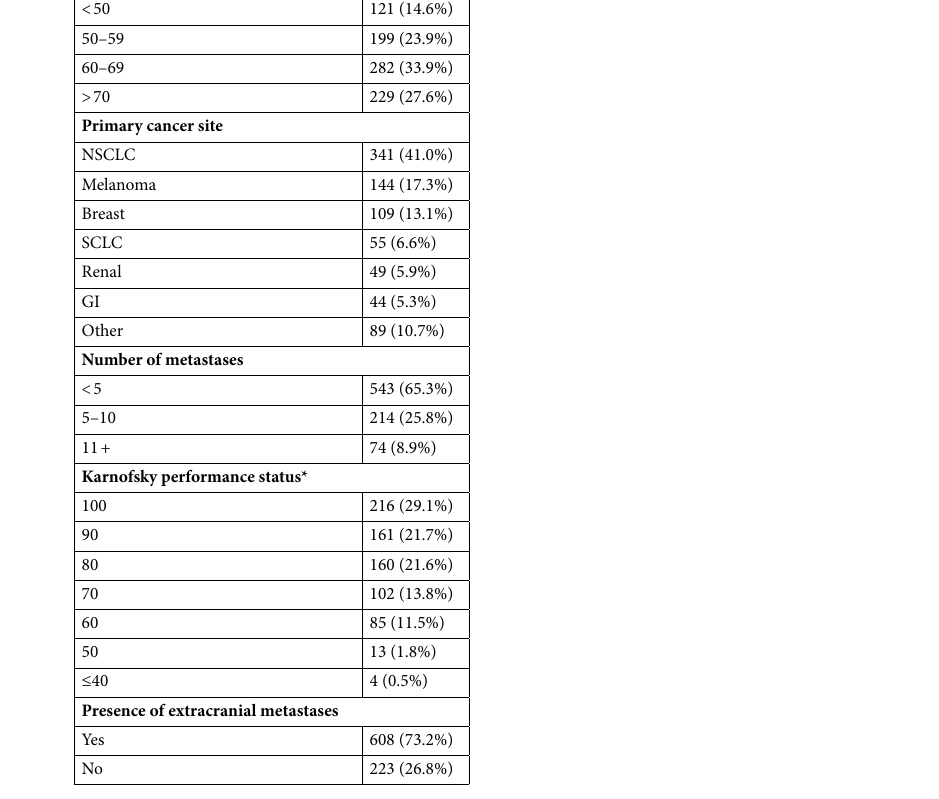
Table 1. Patient demographics. * If